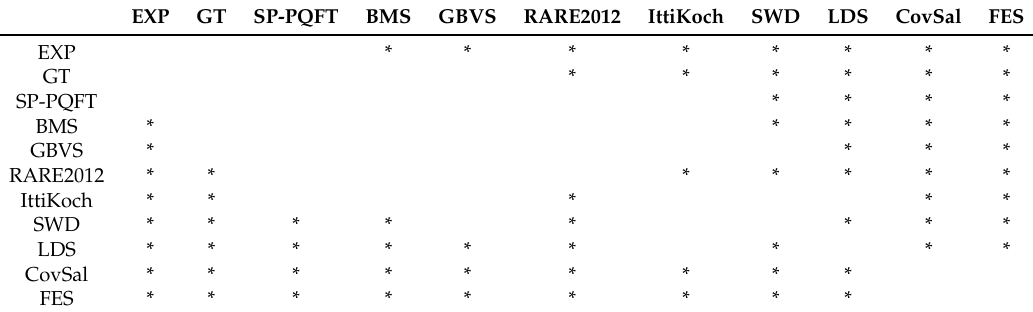
Table 9. Significance of differences of calibration errors between various saliency models taking MCF DIR and removalPercent = 20. The asterisk (*) denotes that according to the t -Student test for either x or y axis the difference was significant ( p <